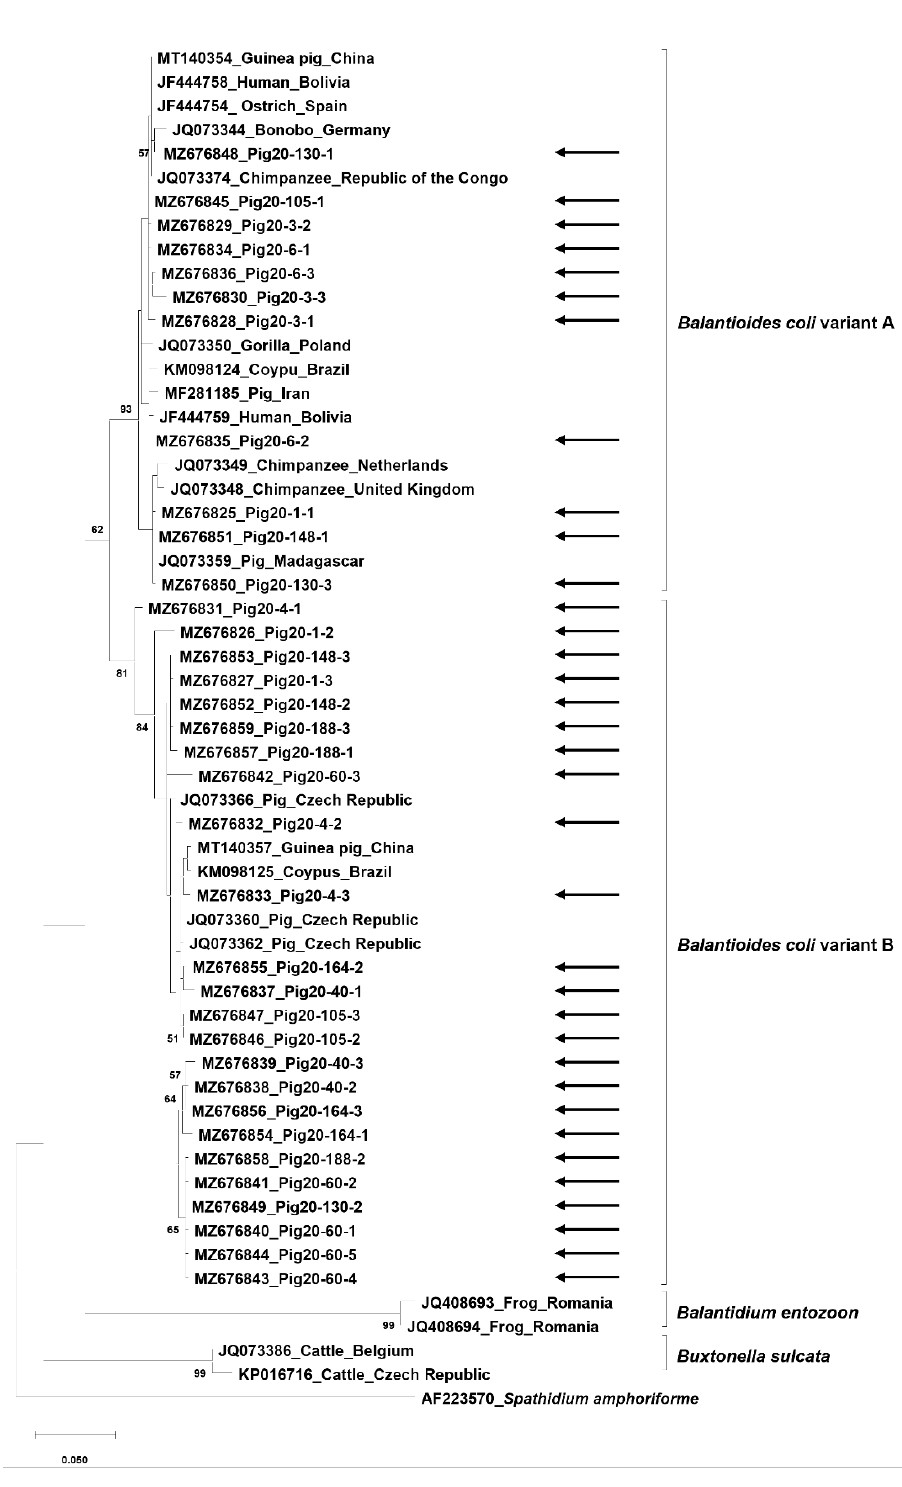
Figure 3. Phylogenetic analysis of Balantioides coli in pigs in Korea. The tree was constructed using MEGA 7.0 and the maximum-likelihood method with 500 replications. The sequences analyzed in this tree were obtained from the GenBank database and are described with their accession num- bers, hosts, and isolated countries. The sequences identified in this study are indicated with ar- rows. Spathidium amphoriforme (AF223570) is included as an outgroup. Bootstrap values less than 40 were omitted.